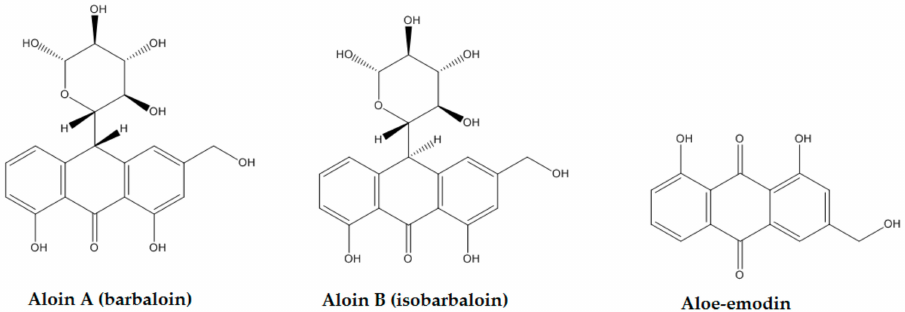
Figure 1. Aloin A, aloin B, and aloe-emodin